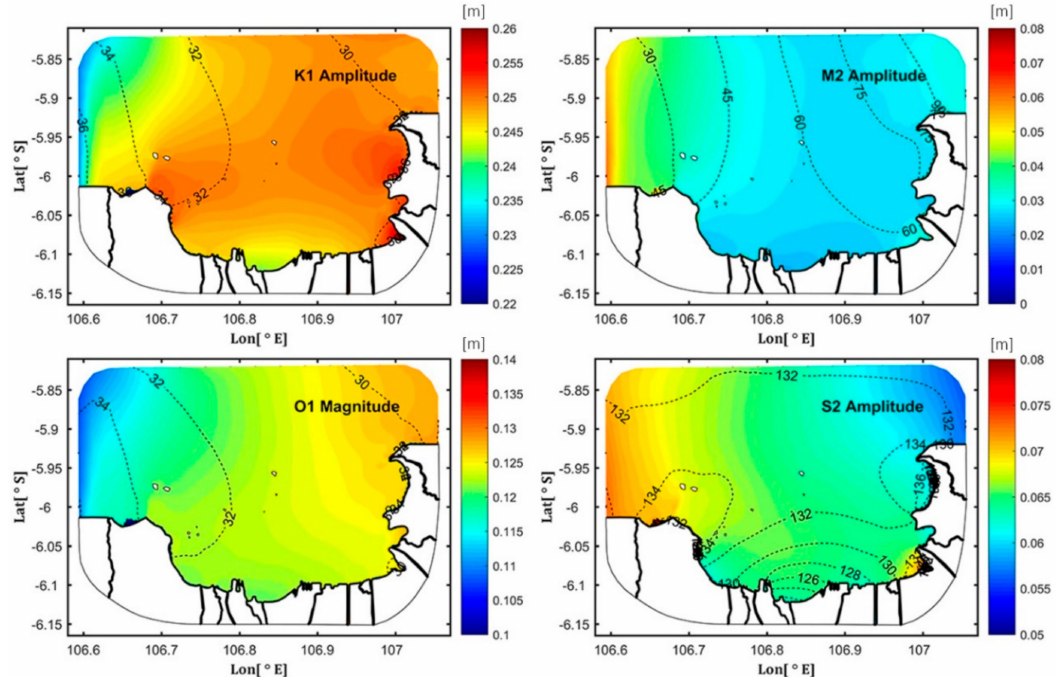
Figure 6. Co-tidal charts of the main tidal constituents (K1, O1, M2, and